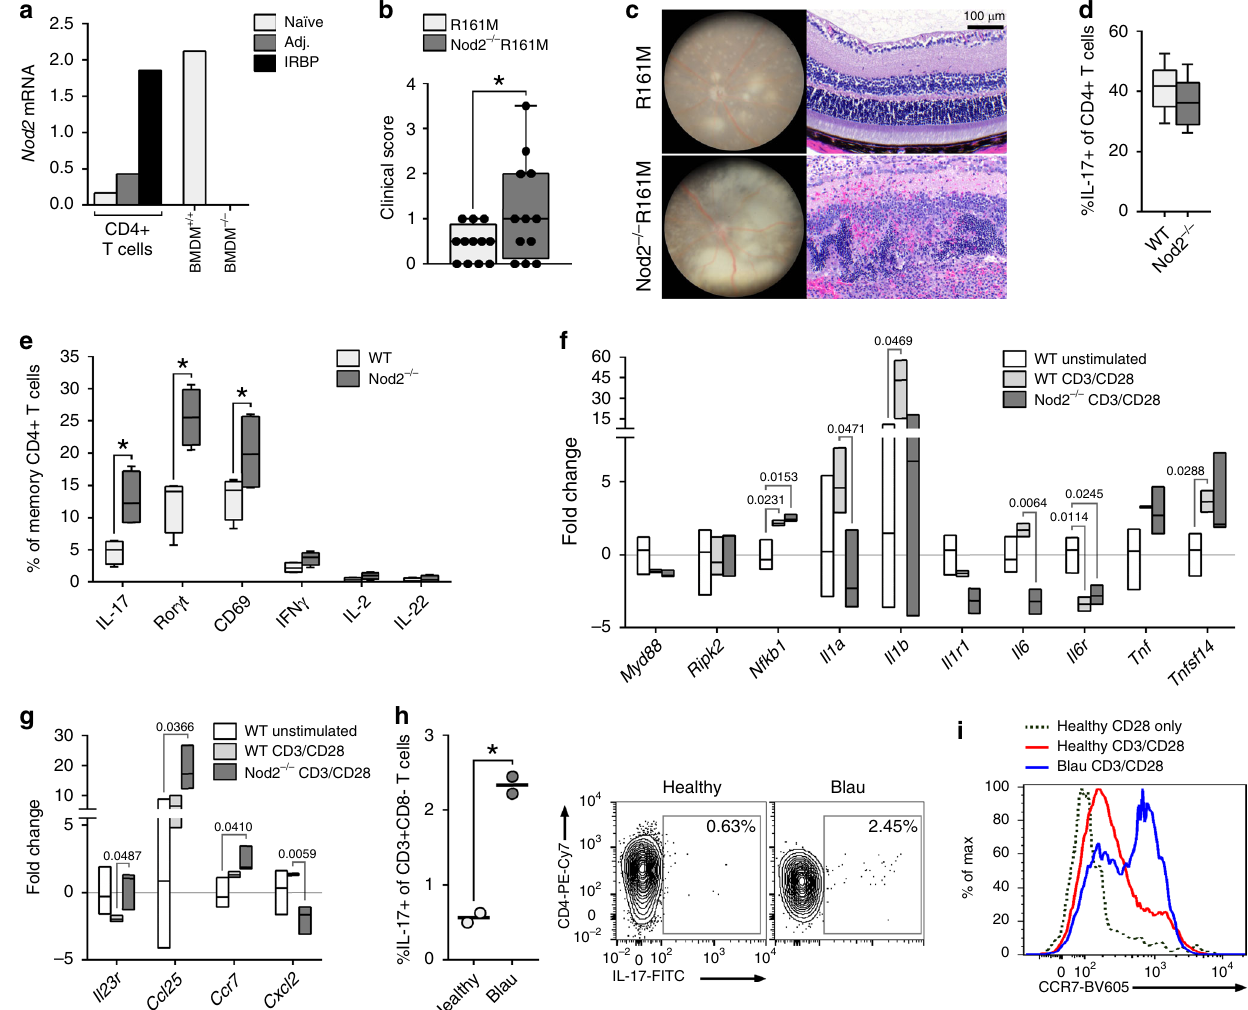
Fig. 7 Nod2 controls Th17 immunity in naïve mice and Blau syndrome. a Nod2 expression in IRBP 1 – 20 – stimulated CD4 + T cells of naïve, adjuvant-only, or immunized WT mice relative to unstimulated CD4 + T cells from naïve WT mice was measured by qPCR. Controls include IFN γ -stimulated WT BMDM and Nod2 − / − BMDM cells. Data are representative of 2 independent experiments, each with n = 5 spleens pooled/genotype. b – c Rag2 − / − hosts reconstituted with CD4 + T cells from naïve R161M or Nod2 − / − R161M mice were assessed for uveitis 7 days post-transfer. Data are combined from 3 independent experiments with n = 12 mice/group. b Clinical uveitis was scored, * p = 0.0500. c Representative fundus and histopathology photographs. d – g T cell responses in naïve WT and Nod2 − / − (C57BL/6 J) mice. d Naïve CD4 + T cells (CD62L hi CD44 - ) from WT and Nod2 − / − mice were differentiated under Th17-polarizing conditions and frequency of IL-17-producing CD4 + T cells (CD4 + CD8 - Thy1.2 + IL-17 + ) was determined by fl ow cytometry. Data are combined from 2 independent experiments for n = 8 mice/genotype. e Frequency of memory (CD62L - CD44 + ) CD4 + T cells from naïve WT or Nod2 − / − mice expressing indicated factors was determined by fl ow cytometry 5 days post-stimulation with anti-CD3/anti-CD28 mAb. Data is representative of 3 independently performed experiments, each with n = 4 mice/genotype; * p = 0.0286 for all indicated comparisons. f – g Memory CD4 + T cells from naive WT or Nod2 − / − mice stimulated 16 h with anti-CD3/anti-CD28 mAb were analyzed by multiplex-qPCR. Transcripts are relative to unstimulated control memory CD4 + T cells of WT mice (horizontal line), with n = 3 mice/condition. h – i PBMCs of two healthy controls or two Blau syndrome patients were stimulated with anti-CD3/anti-CD28 mAb for 5 days then with PMA/ionomycin for 4 h. Experiment was repeated twice. h Frequency of IL-17-producing CD4 + T cells (CD3 + CD4 + CD19 - IL-17 + )(* p = 0.0055) and representative contour plot. i Representative histogram showing MFI of CCR7 by CD4 + T cells (CCR7 + CD3 + CD4 + CD19 - ). Data are box-whisker plots showing median with 25 – 75th percentile and min – max range ( b , d ), box-whisker plots showing median with 10 – 90th percentile ( e ), or fl oating bars showing median and min – max range ( f , g ). Dots represent individual values ( b , h ). Statistical differences were calculated using two-tailed Mann – Whitney U test ( d , e ) or unpaired, two-tailed Student ’ s t -test ( b , f – h ). Source data are provided as a Source Data fi le. +